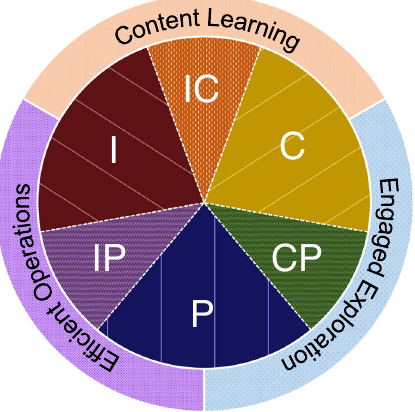
FIG. 5. A depiction of the full modal taxonomy including the three overarching objectives that mediate UEs ’ pedagogical activity among and within the modes. The inner circle orients the three solo modes and the mixed modes with respect to one another. The outer circle denotes three overarching objectives, each patterned with varying densities of dots, toward which UEs direct their, and their groups ’ activity, based on their choice of mode and an orientation toward process or outcome. Each objective mediates two solo modes and their shared mixed mode in this